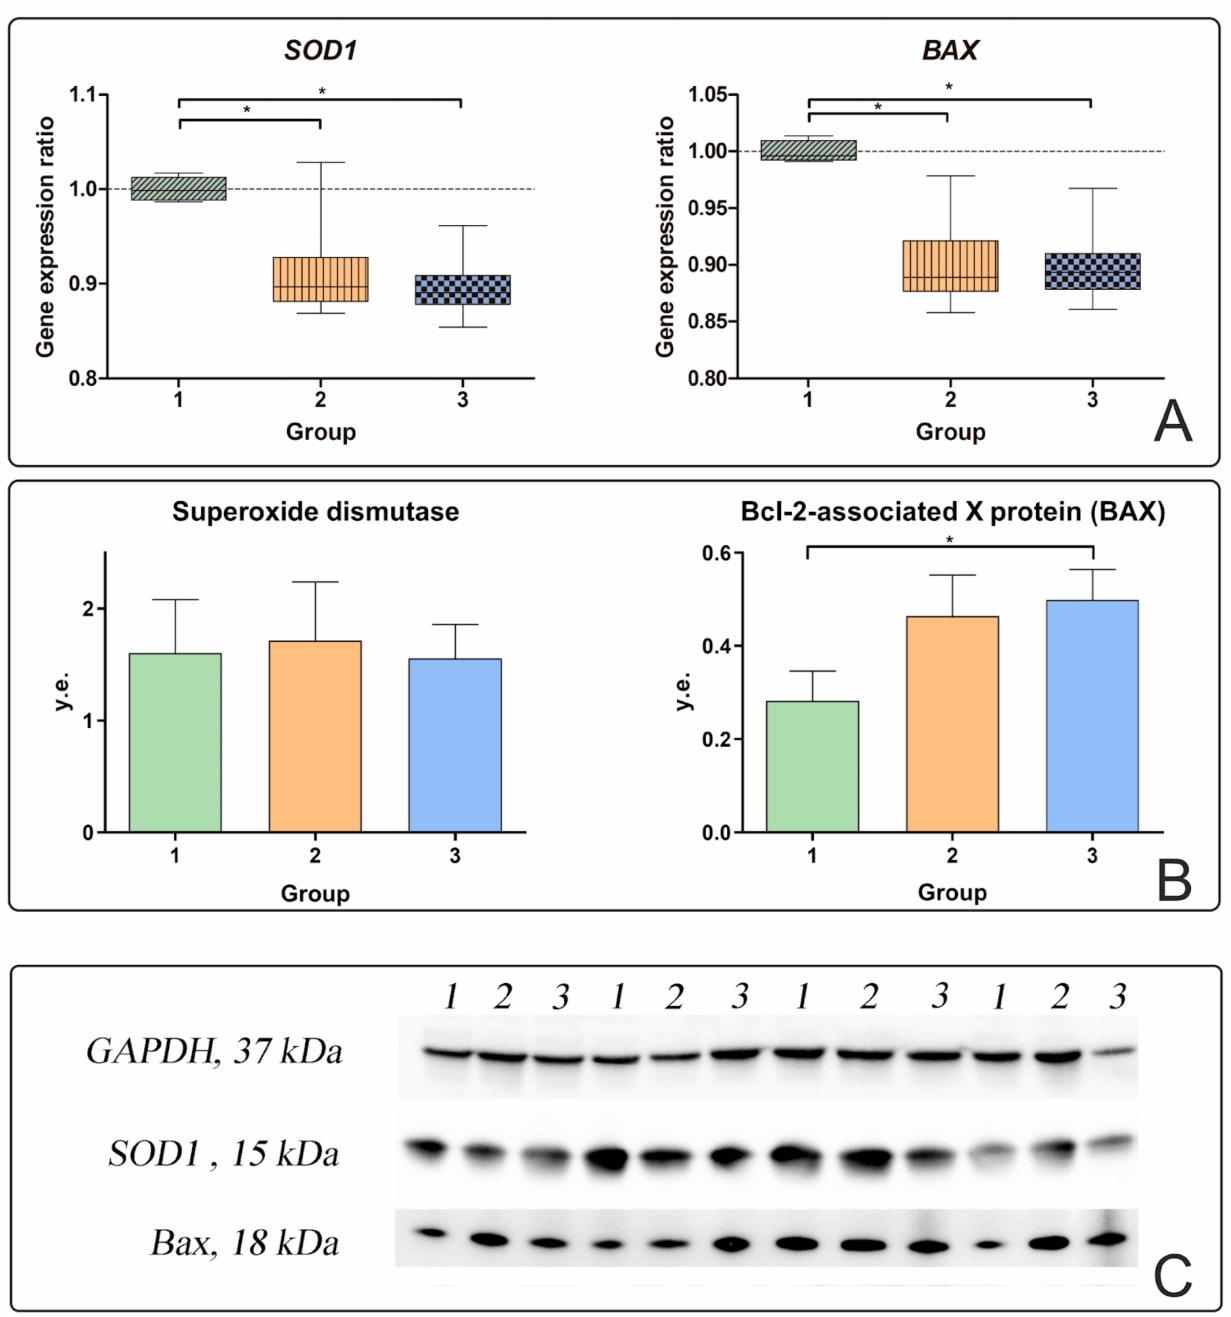
Figure 2. Characteristics of apoptotic processes in the liver in obese patients with and without T2DM. 1—control group; 2—obesity group without T2DM; 3—obesity group with T2DM; ( A ) gene expression ratio of SOD1 and BAX in liver biopsies; ( B ) production of superoxide dismutase (SOD1) and Bcl-2-associated X protein (BAX) proteins in liver biopsies; ( C ) Western blot analysis of liver biopsies. The significance was determined using the Mann–Whitney criterion for two independent samples (* p <